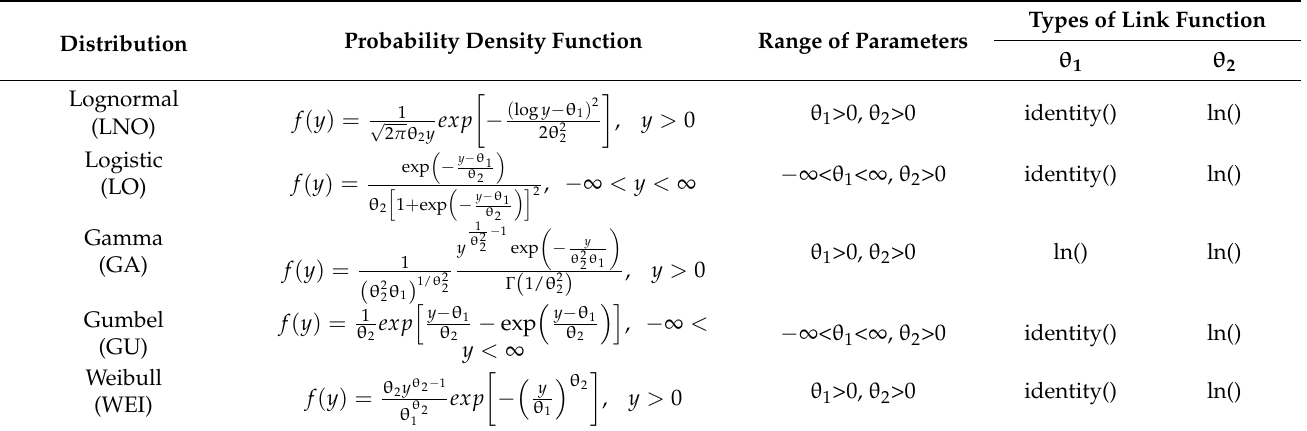
Table 1. Summaries of probability density function (PDF) of five distributions and the link functions used to model flow indices.